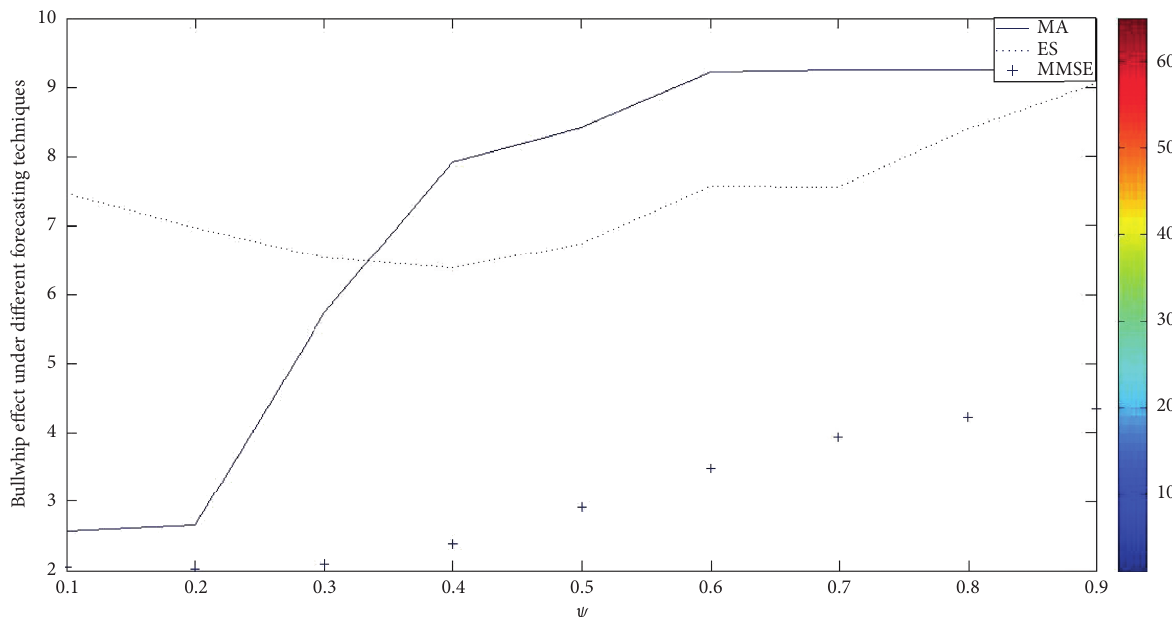
Figure 10: The impact of ψ on the bullwhip effect using different forecasting techniques.